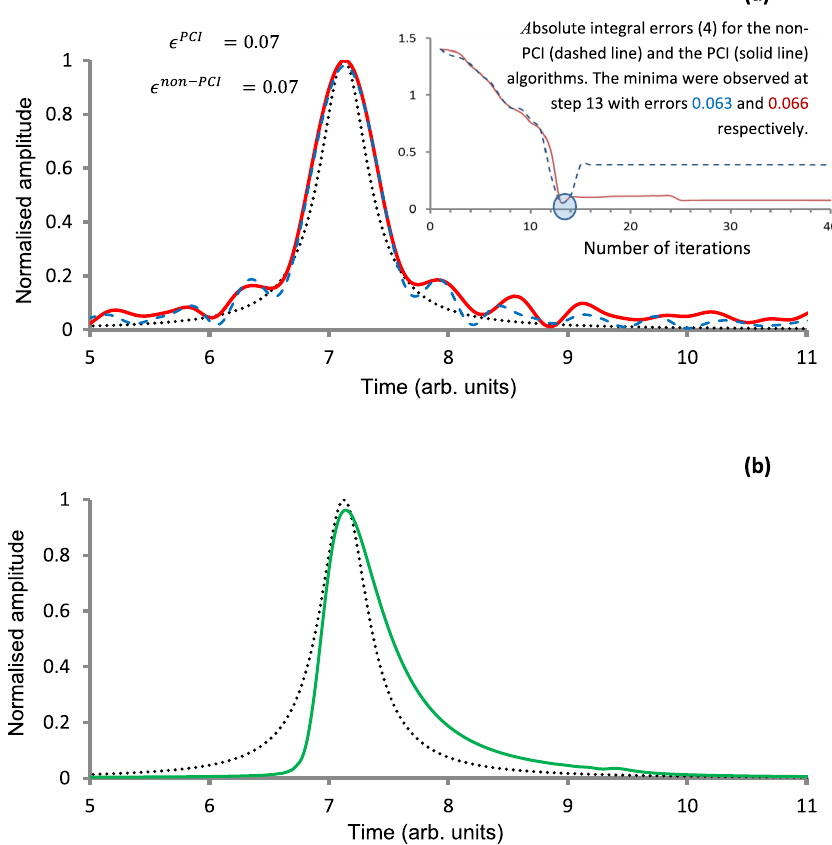
FIG. 6. Reconstruction of a Lorentz-type function ( α ¼ 0 . 3 ; t 0 ¼ 0 ) based on: (a) a non-PCI (dashed line) and the PCI (solid line) algorithms; (b) minimal phase reconstruction (solid green line). The black dotted line shows the original function. The inset to (a) shows the integral errors (4) for the non-PCI (dashed line) and the PCI (solid line) algorithms as a function of the iteration